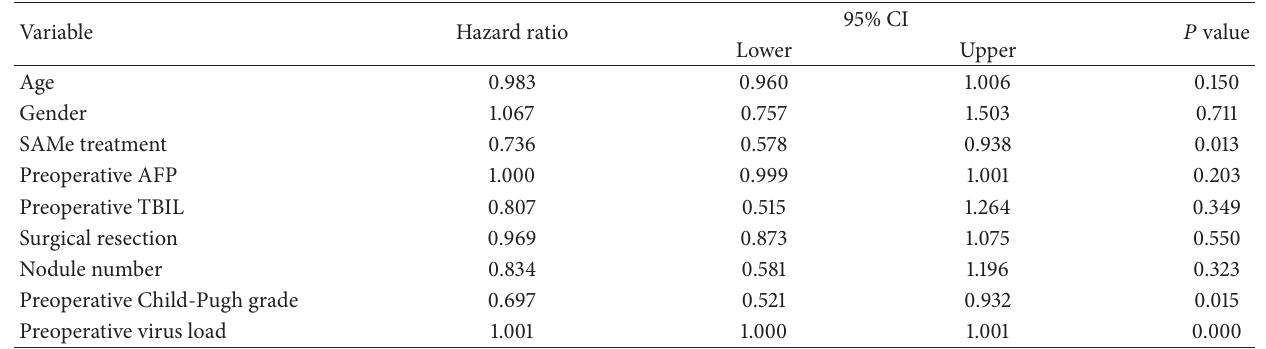
Table 3: Results of Cox regression model analysis of patient survival in group